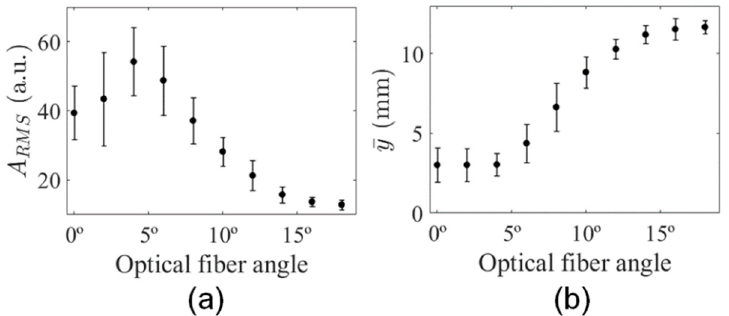
Figure 9. ( a ) Mean square root of PA signal and ( b ) mean depth of PA signal as a function of illumination angle. Figure 10. ( a ) Final PA image of a single image slice of the phantom, ( b ) PA signal profile of this PA image shows the contribution of all illumination angles to generate PA signal at depths greater than 10 mm, and ( c ) SNR as a function of image depth.